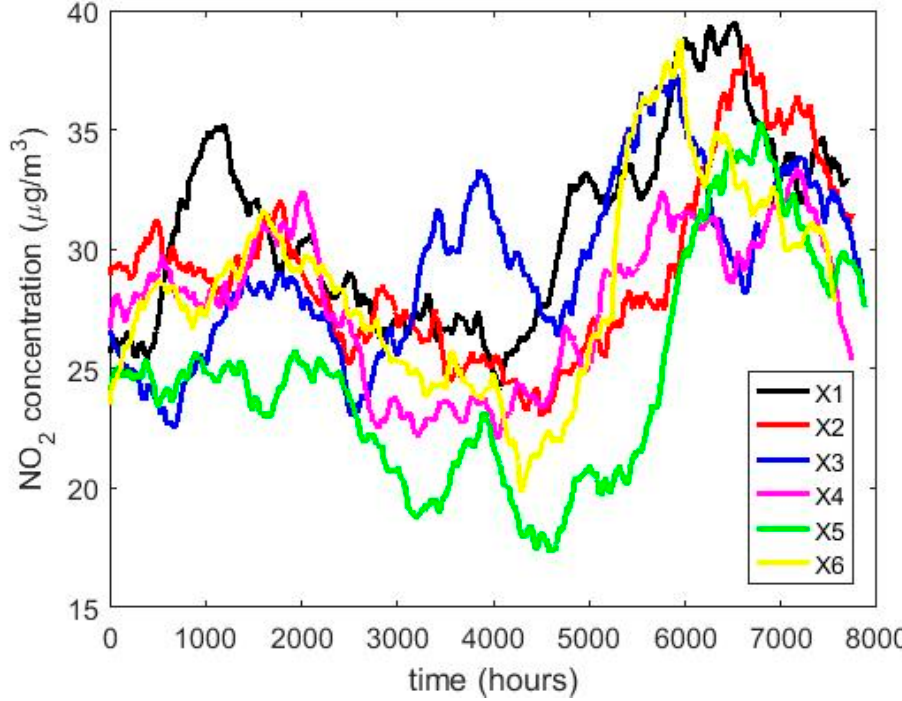
Figure 3. Moving average of the NO 2 concentration measurements during the years from 2008 to 2013: X 1 ( 2008 ) , X 2 ( 2009 ) , X 3 ( 2010 ) , X 4 ( 2011 ) , X 5 ( 2012 ) , and X 6 ( 2013 ) .